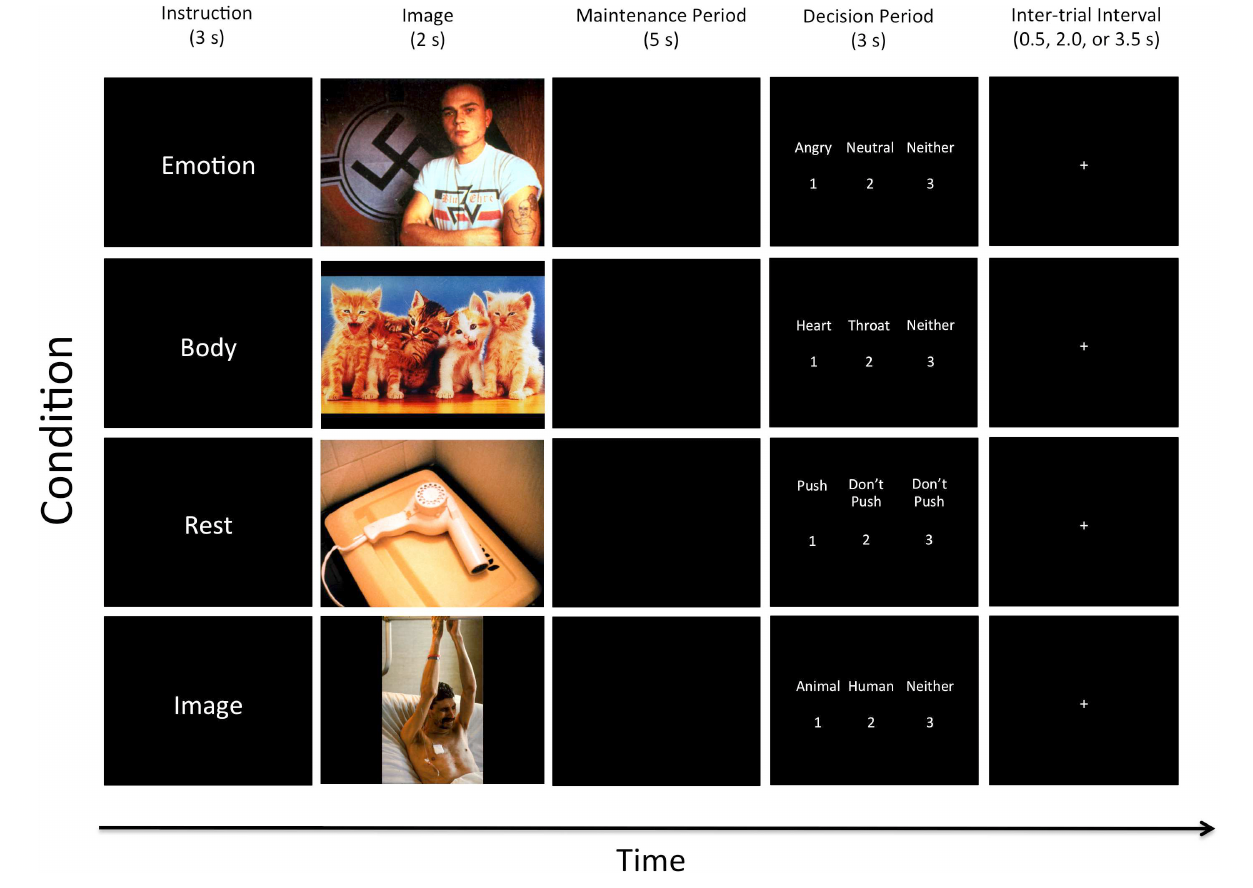
FIGURE 1 | Illustration of the four task conditions. After the appearance of each instruction, an emotionally pleasant, unpleasant, or neutral image was presented followed by a maintenance period. Examples of two unpleasant, one pleasant, and one neutral image are shown here (from top to bottom). All contrasts reported in this manuscript compare the 5-s maintenance periods between the Emotion, Body, Rest, and Image conditions. The decision period that followed included making a simple identification judgment from memory that included three options (where the correct answer was different depending on the instruction associated with that condition; described in greater detail in the text). Participants did not know what condition-specific options would be presented on a given trial, but could select “Neither” if the available options on that trial were both